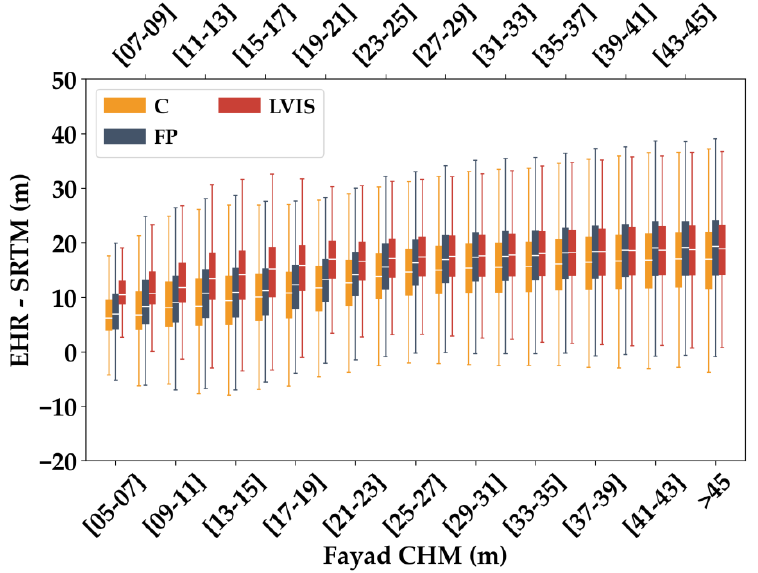
Figure 4. Boxplots of the difference between the elevation of each waveform’s highest return (EHR) and SRTM from GEDI’s coverage (C) and full-power (FP) lasers, as well as those from LVIS.